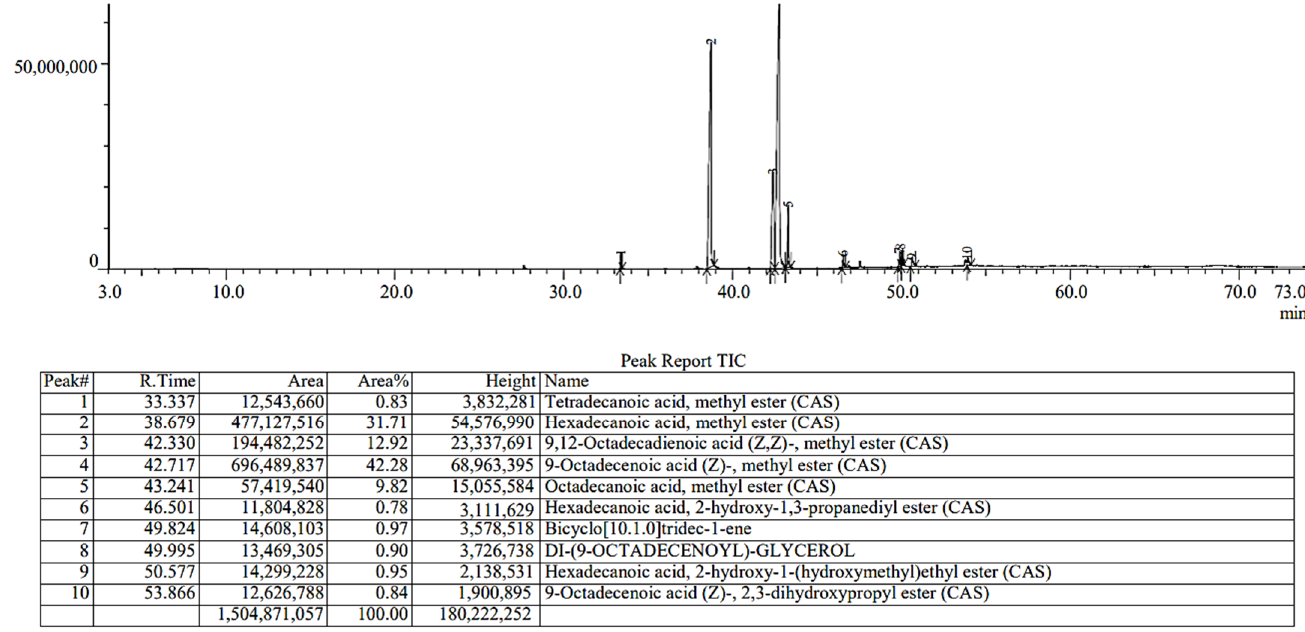
Figure 1. GC-MS analysis of CPO before fractionation.